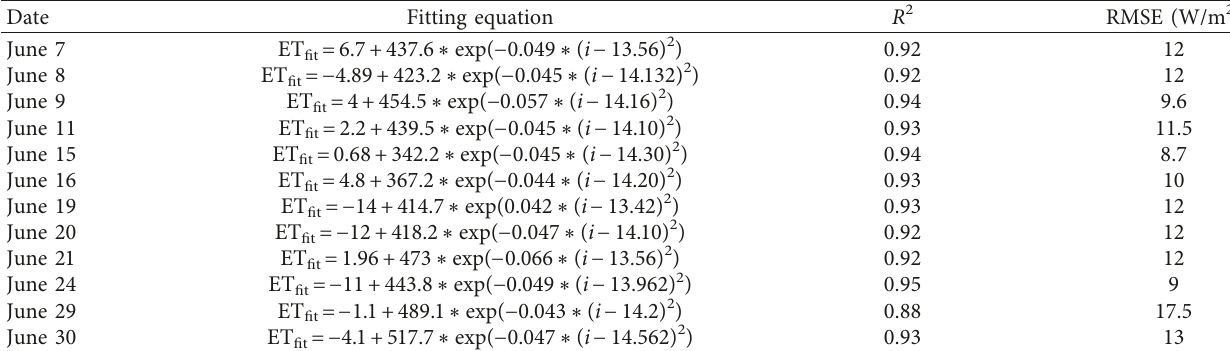
Table 4: Gaussian fitting results on ET measurements at EC17 on cloud-free days in June